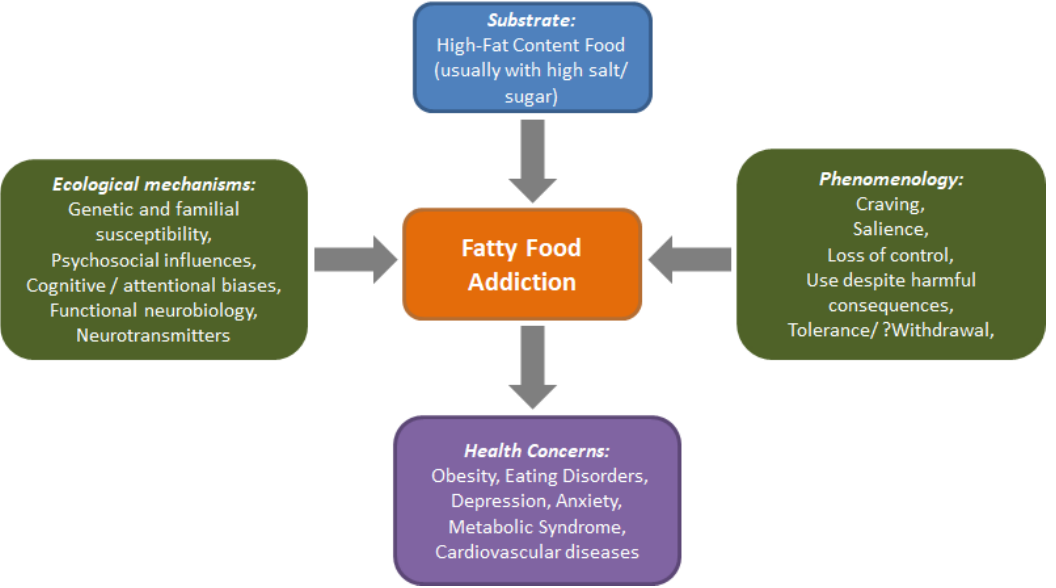
Figure 3. Schematic representation of addiction to fat.